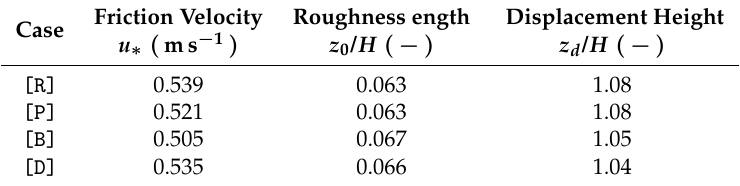
Table 4. Similarity scaling parameters from the different computational